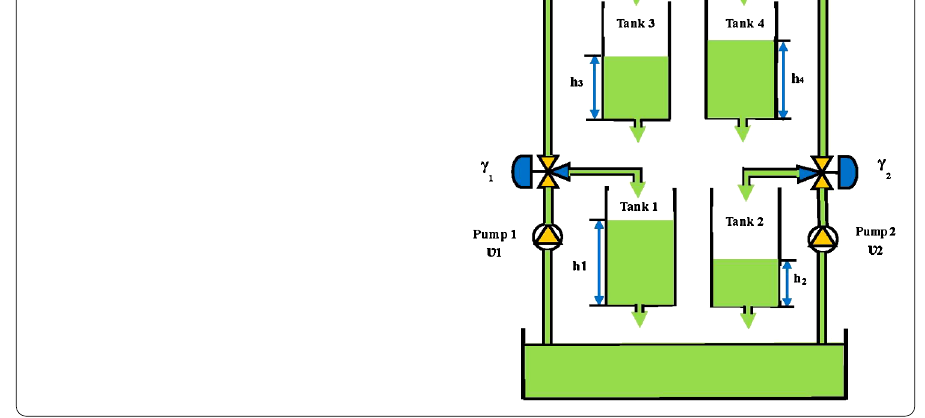
Figure 1 Schematic representation of the QTPS. Source: